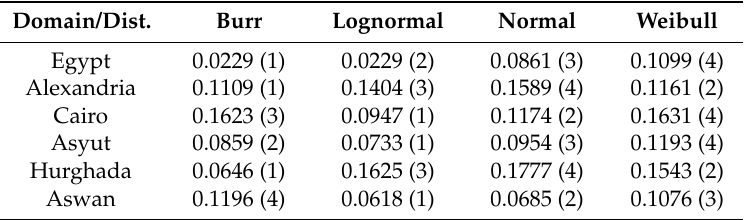
Table 9. Goodness of fit measurement for data from Egypt and the five cities. The numbers in parentheses are